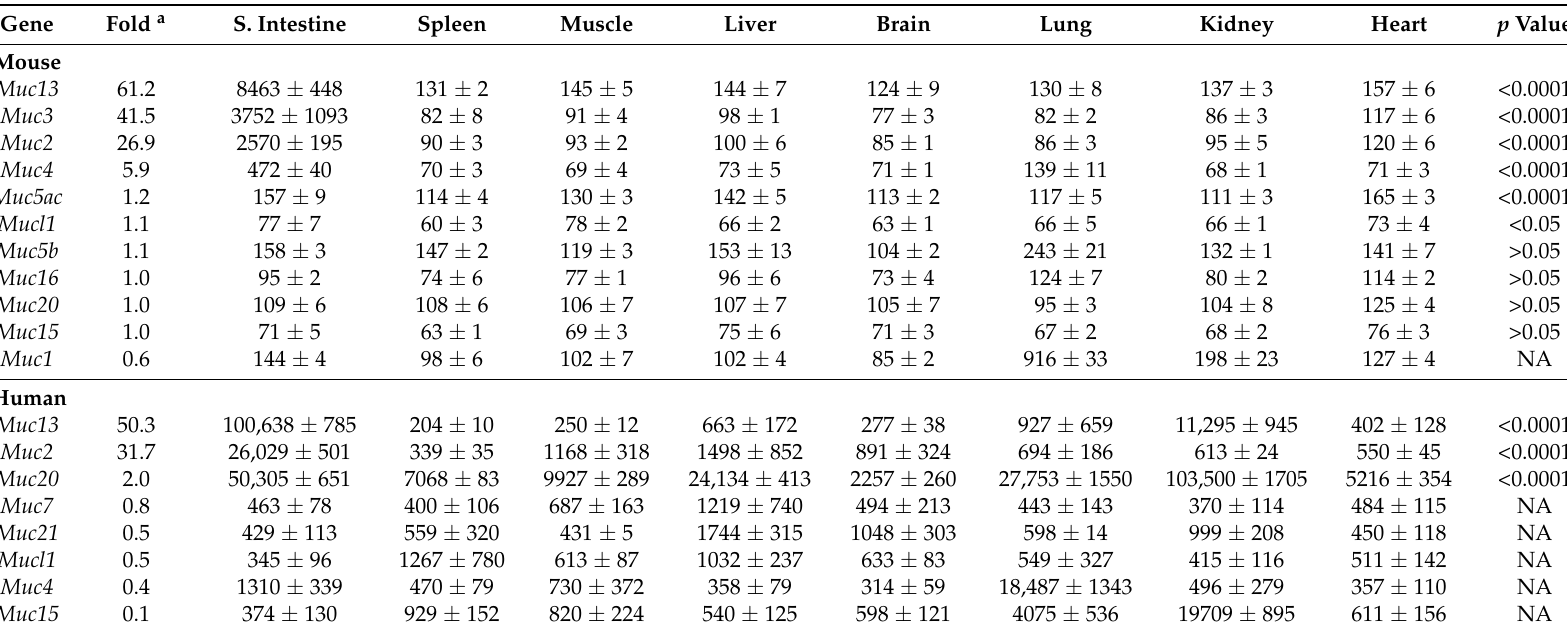
Table 1. Microarray data analysis for mucin gene expression patterns in various tissues based on GDS3142 for the mouse and GDS3113 for the